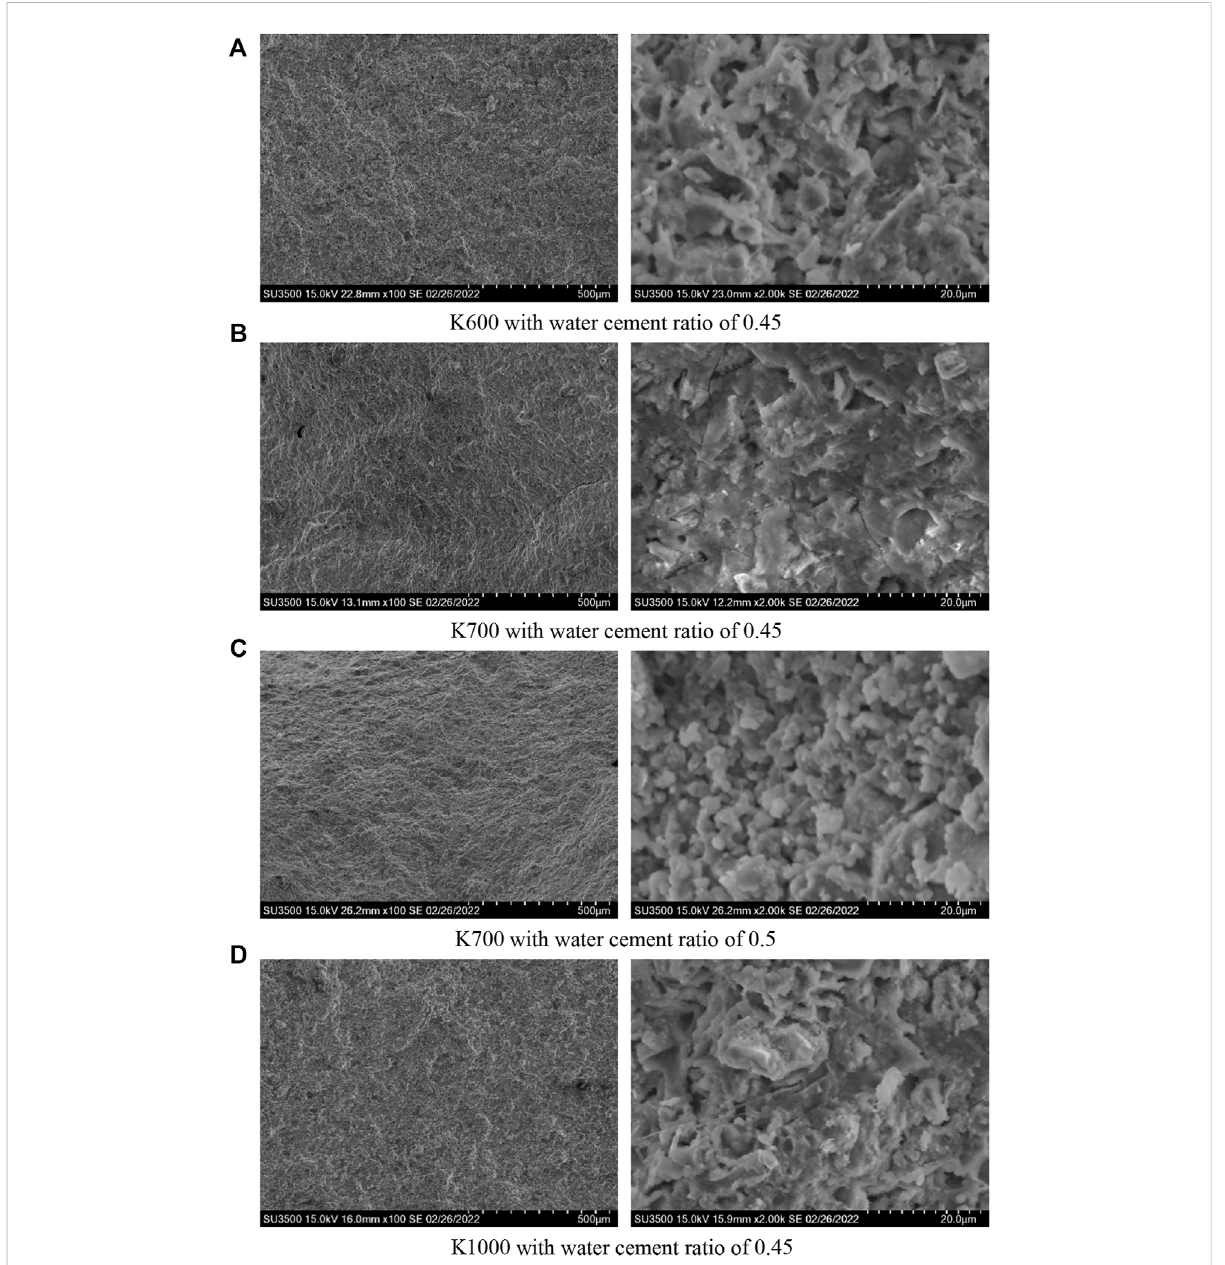
FIGURE 4 SEM of super fi ne cement test